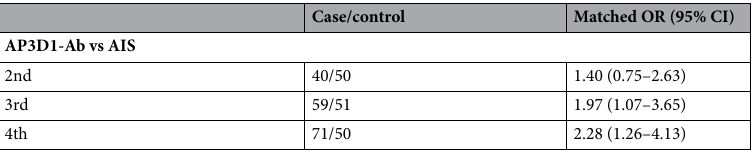
Table 8. Results of JPHC cohort subjects. Age-, sex-, and area-matched, conditional odds ratios, and 95% confidence intervals of AIS according to AP3D1 antibody markers. OR odds